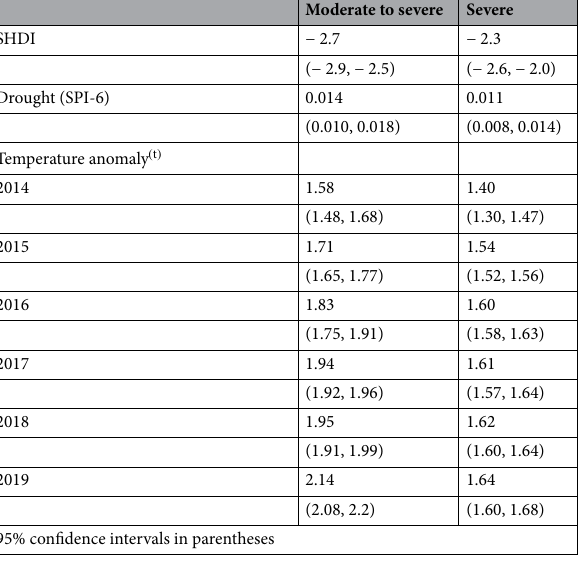
Table 1. Main regression